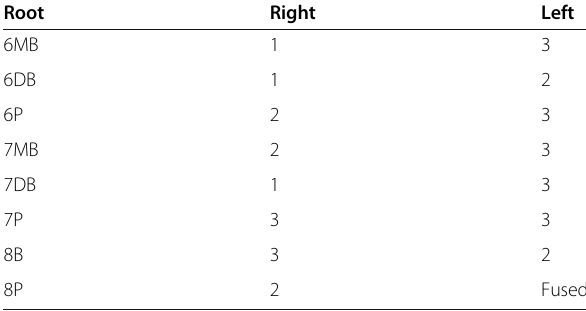
Table 1 Scoring of the relationship of the roots of the maxillary right and left molars to the MSF using CBCT, (R = right, L = left,